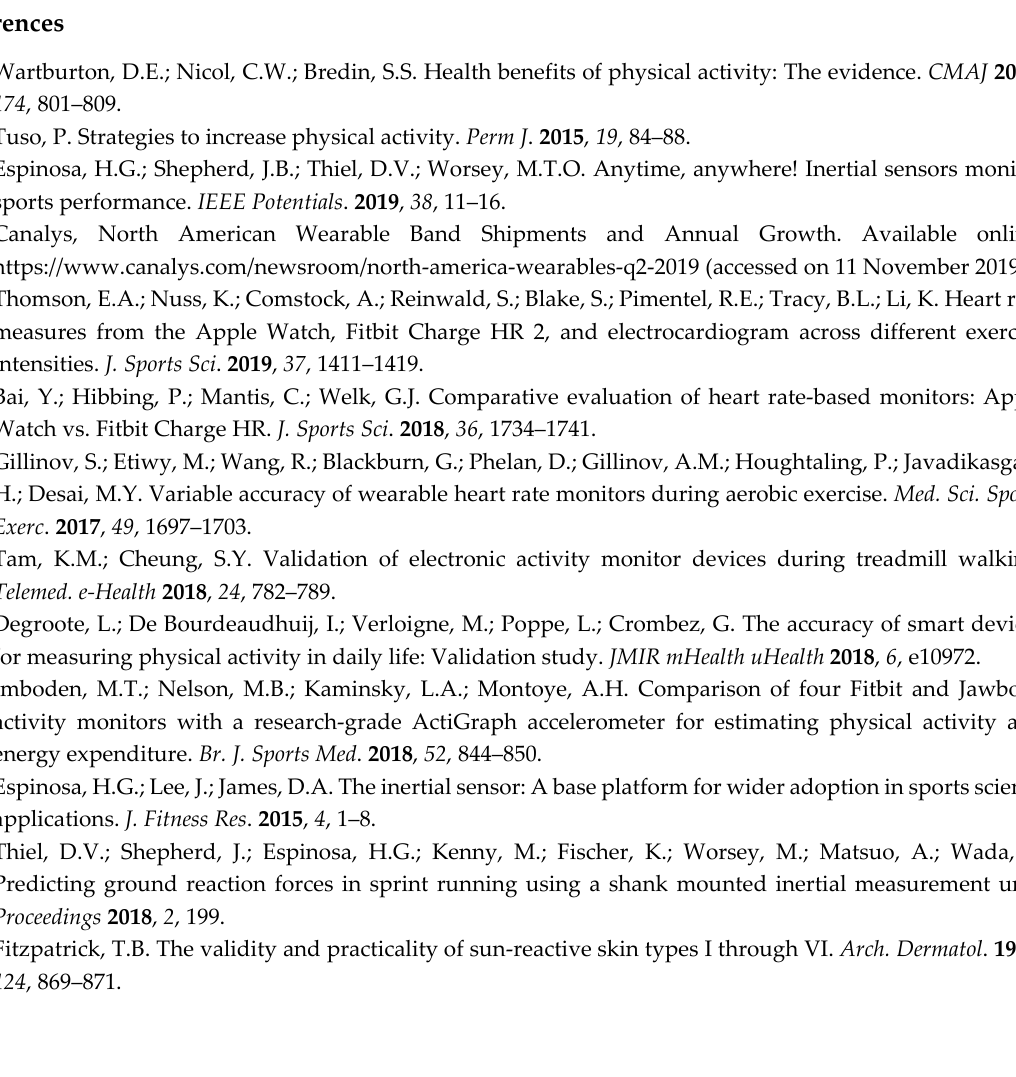
Figure 5. Correlation (left column) and Bland–Altman analysis (right column) for the Apple watch (AW) and IMU heart rate data on walking (top row) and jogging (bottom row). Conflicts of Interest: The authors declare no conflict of